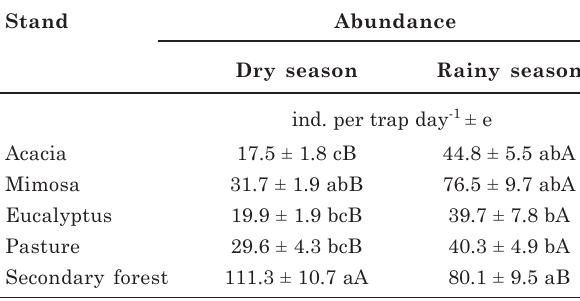
Table 1. Ranking according to the change index V, indicating inhibition or stimulation of abundance of soil fauna groups in response to the soil management system (modified by Wardle, 1995)